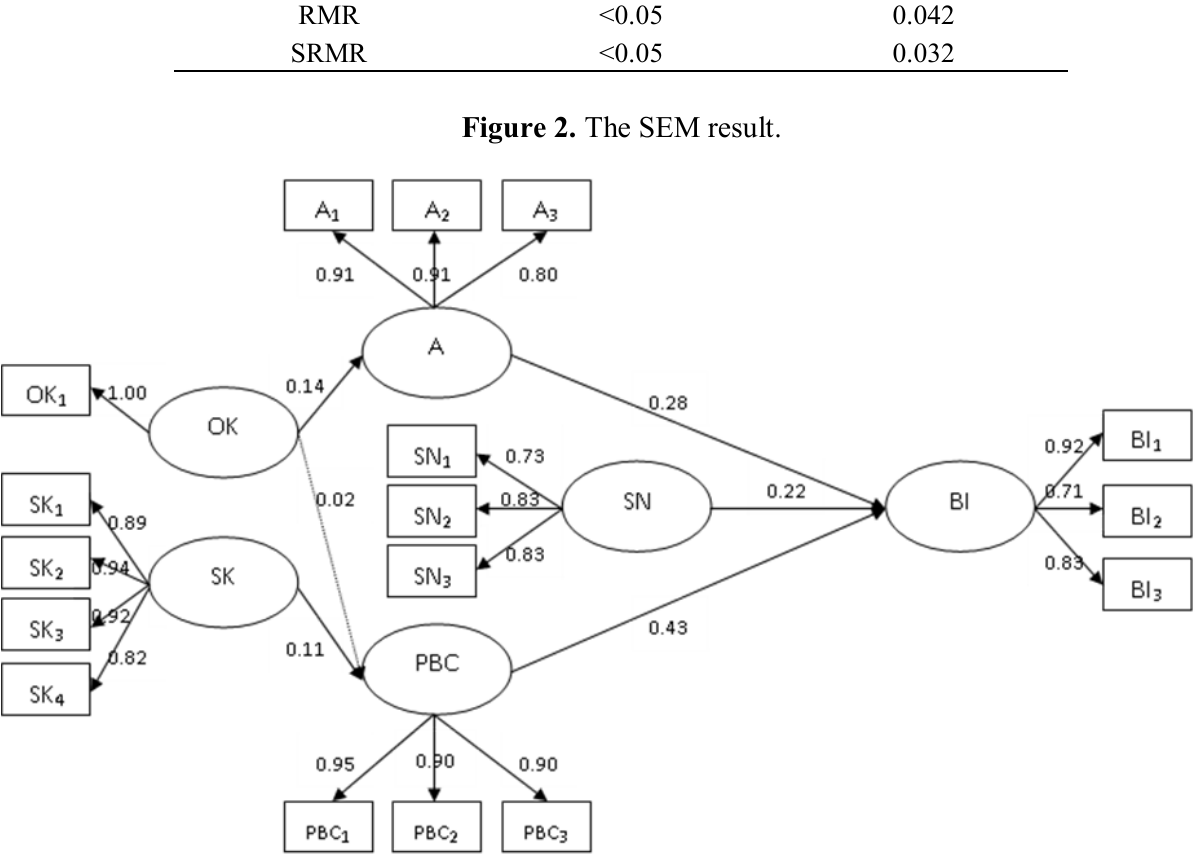
Figure 2. The SEM